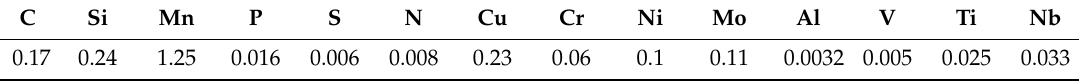
Table 2. Welding parameters.